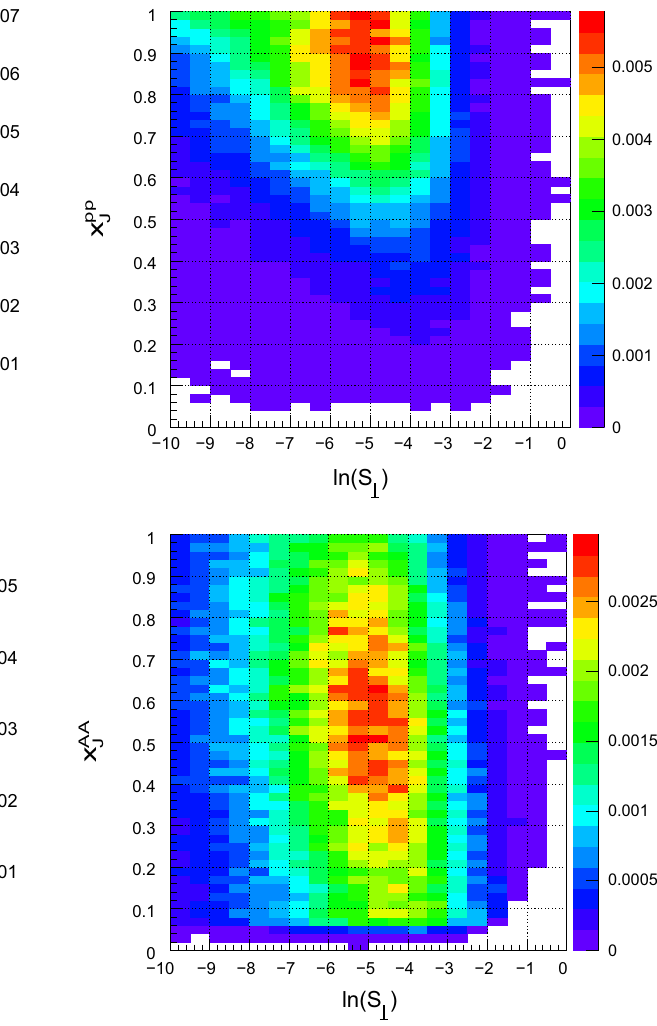
Fig. 9 Correlation between S ⊥ and x J for n jet = 2 events in p+p (top) and Pb+Pb (bottom) collisions at